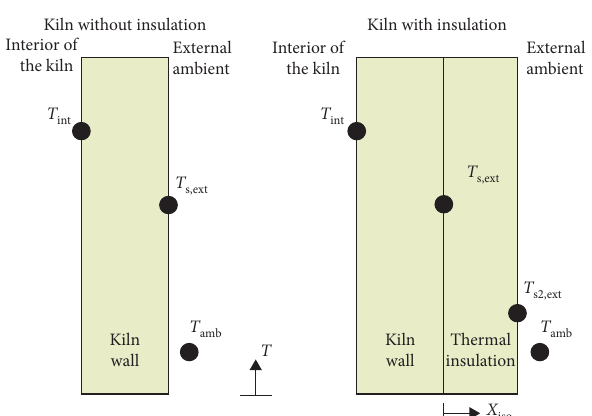
Figure 3: Considerations for analysis of the kiln with thermal